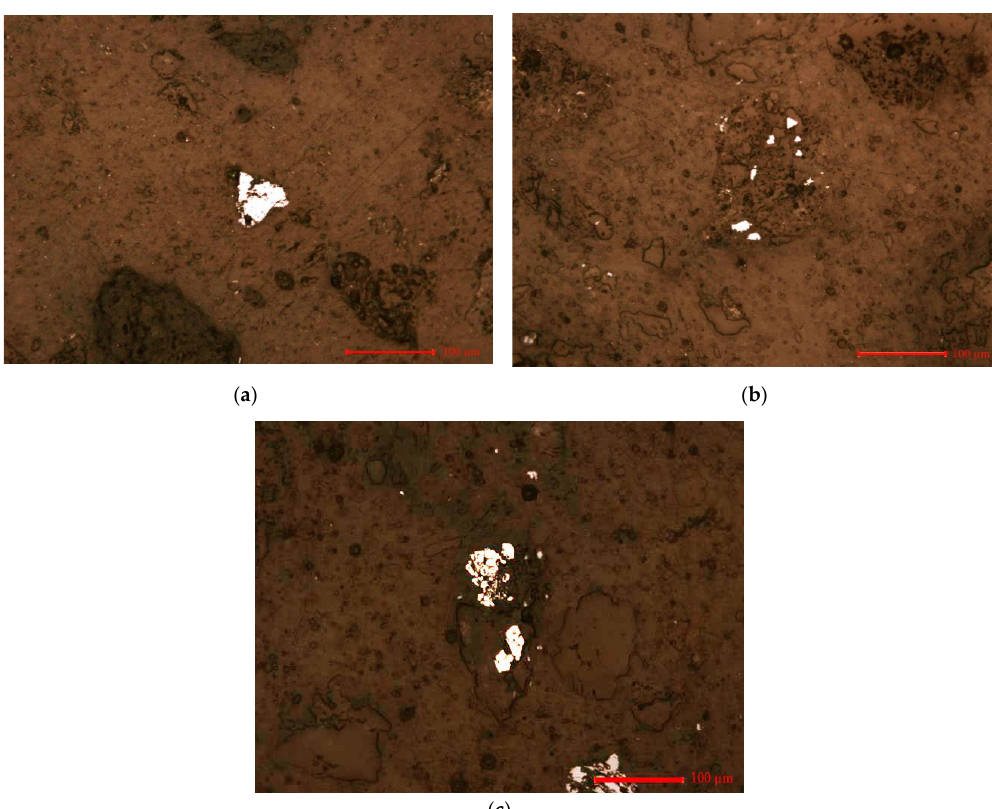
Figure 2. Optical microscopy (x200) images of the minerals before bioleaching: Polished section of mine tailings, ( a ) Single grain of arsenopyrite; ( b ) Arsenopyrite in non-ore forms; ( c ) Pyrite (light yellow) in a non-ore fragment; hematite (gray).